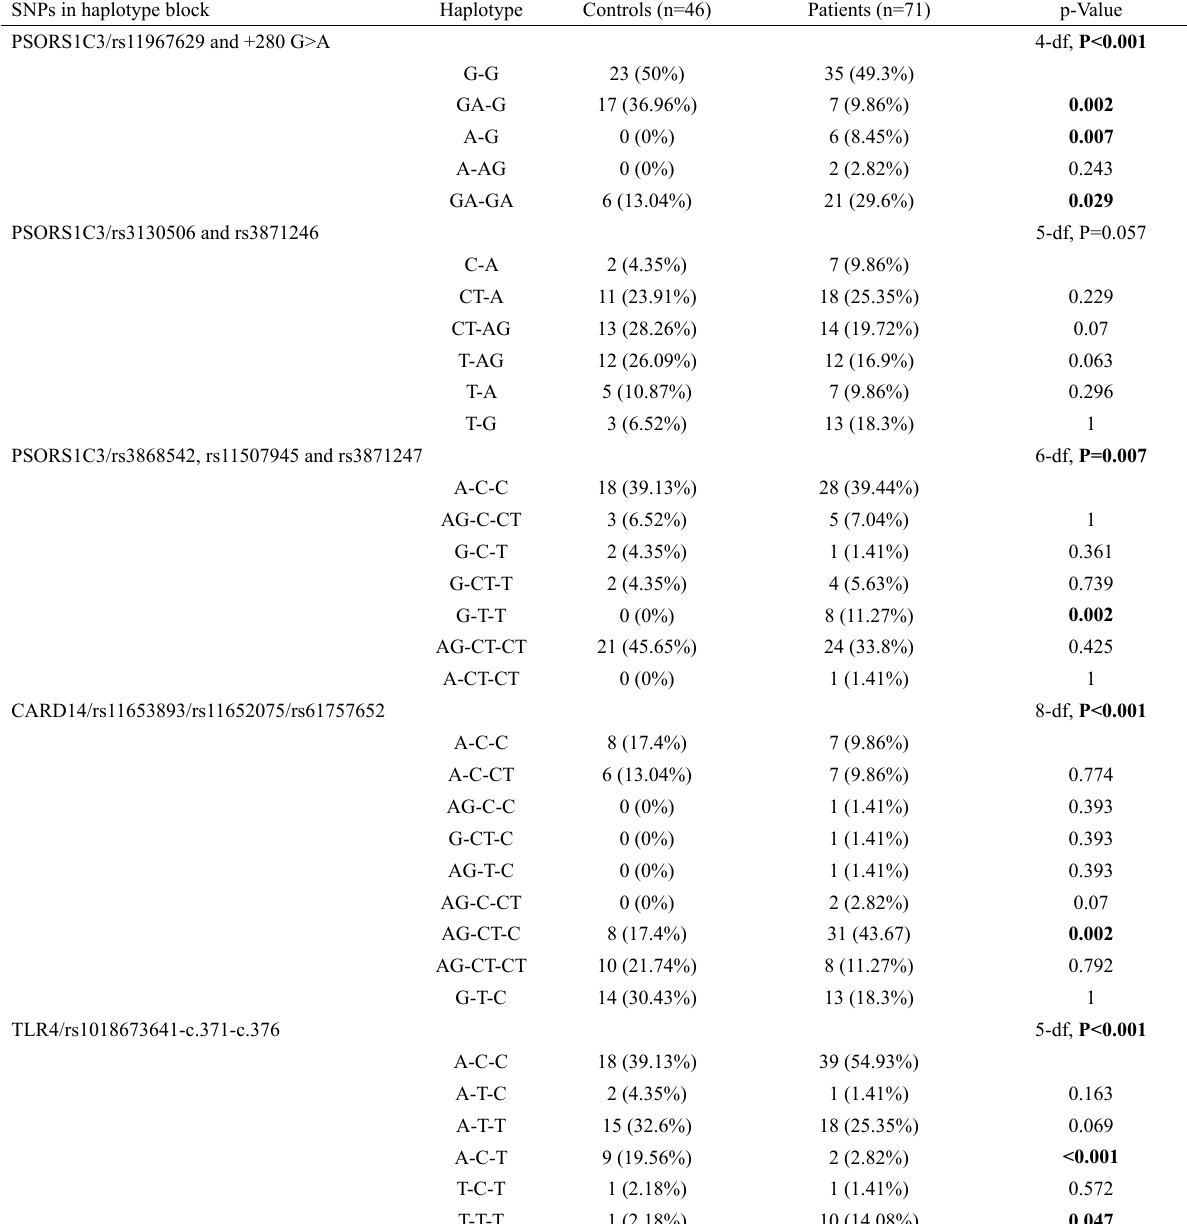
Table 3 – Comparison of haplotype frequencies of TLR4, CARD14 and PSORS1C3 variants between psoriatic patients and controls. SNPs in haplotype